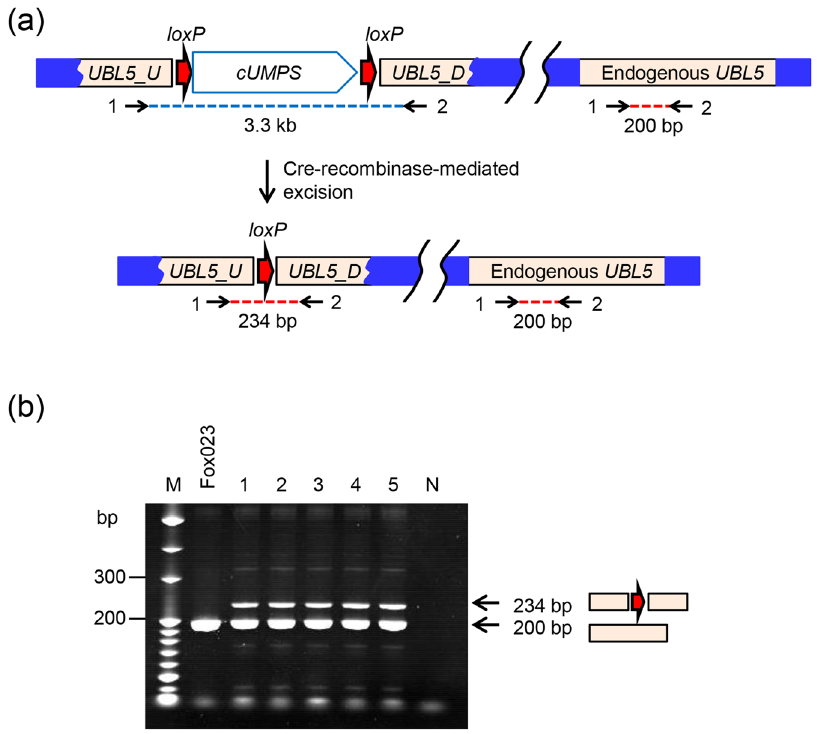
Figure 2. PCR analysis to detect the Cre-recombinase-mediated excision of the loxP_cUMPS_loxP sequence from strain Fox023. ( a ) The structure of the loxP_cUMPS_loxP sequence integrated in the chromosome of strain Fox023. The loxP sites are indicated as red arrows, the UBL5 sequence as cream boxes, and irrelevant chromosome regions as blue boxes. PCR primers UBLF2 ( 1 ) and UBLR2 ( 2 ) were used for amplification of either a 3.3-kb fragment from genomic DNAs without the excision event or a 234-bp fragment from genomic DNAs which underwent Cre-recombinase mediated excision. A 200-bp fragment was also amplified from endogenous UBL5 . ( b ) Agarose gel electrophoresis analyses of the 234-bp and 200-bp fragments amplified from genomic DNAs of indicated strains. Lane M: DNA size marker (20-bp DNA Ladder, TaKaRa) with molecular sizes in bp; Lane Fox023: strain Fox023; Lanes 1–5: five FOA r and Ura − derivatives which underwent Cre- recombinase mediated excision; Lane N: no template.